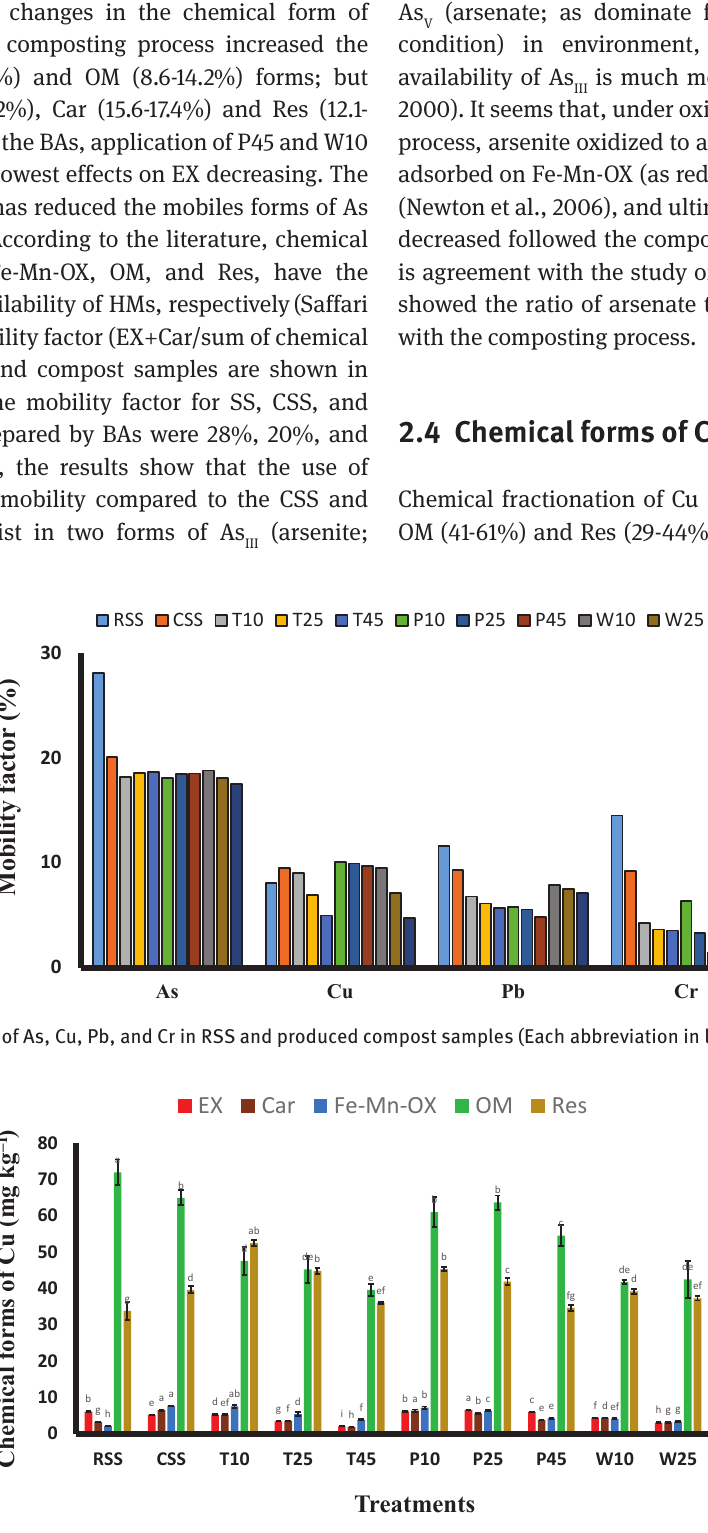
Figure 4: Chemical forms of Cu in RSS and produced compost samples. Different letters (in the same chemical forms of treatments) indicate significant differences among the mean of different treatments (p < 0.05). Error bars represent the standard deviation. (Each abbreviation in x-axis is defined in Table